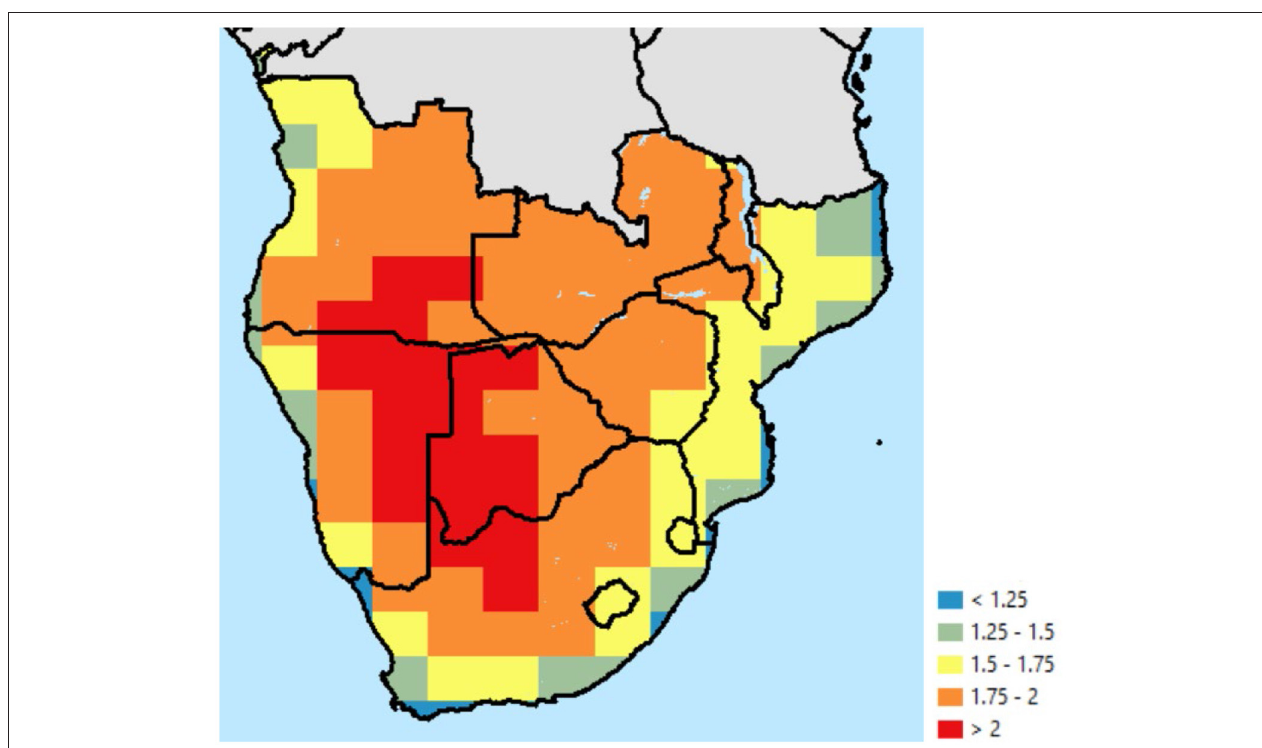
FIGURE 2 | Median projected change in daily maximum temperature across the ensemble of 7,200 smoothed climate change projections from the baseline period (1981–2000) to 2050 under the PF scenario relative to the baseline period, 0 C. Source: Schlosser et al.